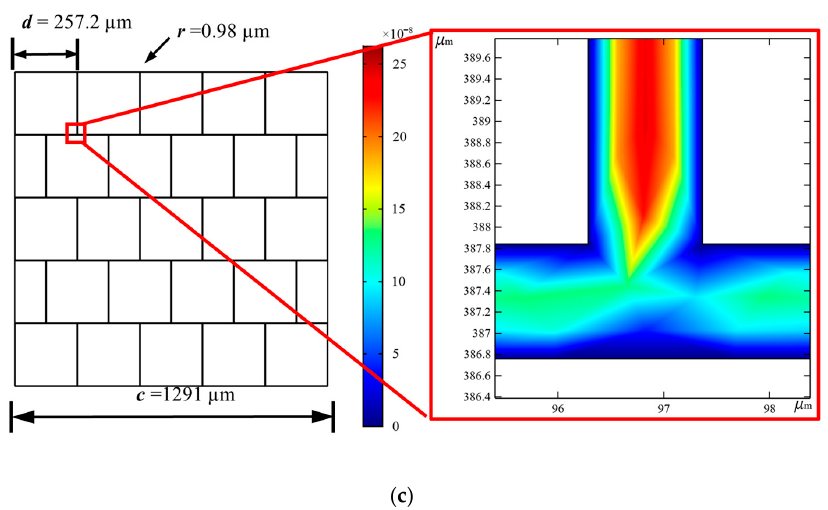
Figure A2. COMSOL model diagram using Jo’s experimental data [46]. ( a ) I = 0.06 mol/L; n f = 0.004; ( b ) I = 0.1 mol/L; n f = 0.007; ( c ) I = 0.12 mol/L; n f = 0.008.